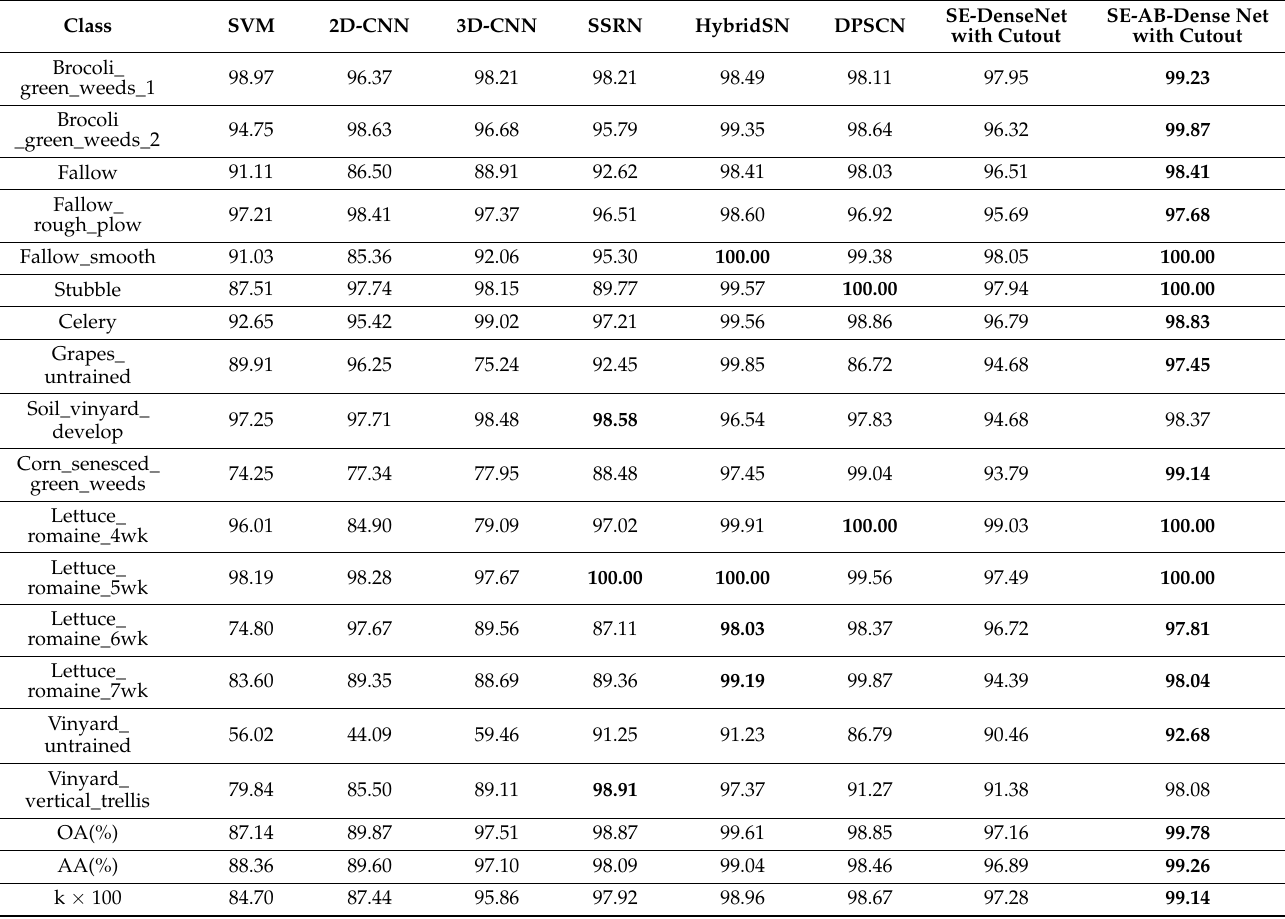
Table 5. Class-wise overall accuracy (OA%), average accuracy (AA%), and k kappa are represented for the Salinas dataset. This table displays the best accuracy of distinct classes obtained in each classifier (bold highlighted